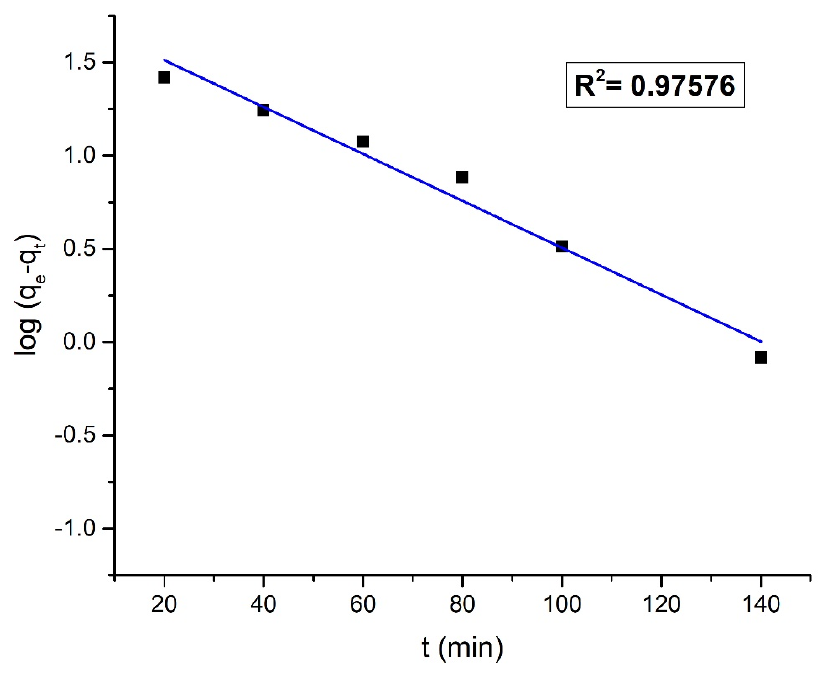
Figure 16. Pseudo-first-order kinetic model plot.